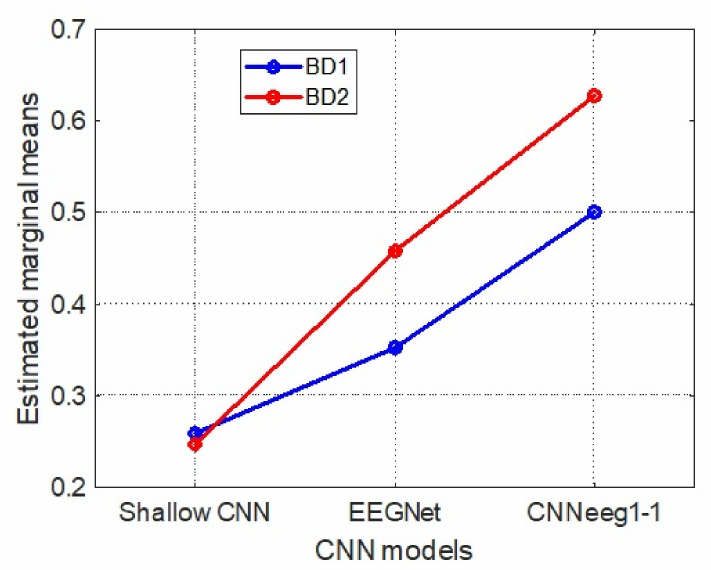
Figure 15. Marginal measures in the inter-subject training classification for the Shallow CNN, EEGNet, and CNNeeg1-1 algorithms using BD1 and BD2